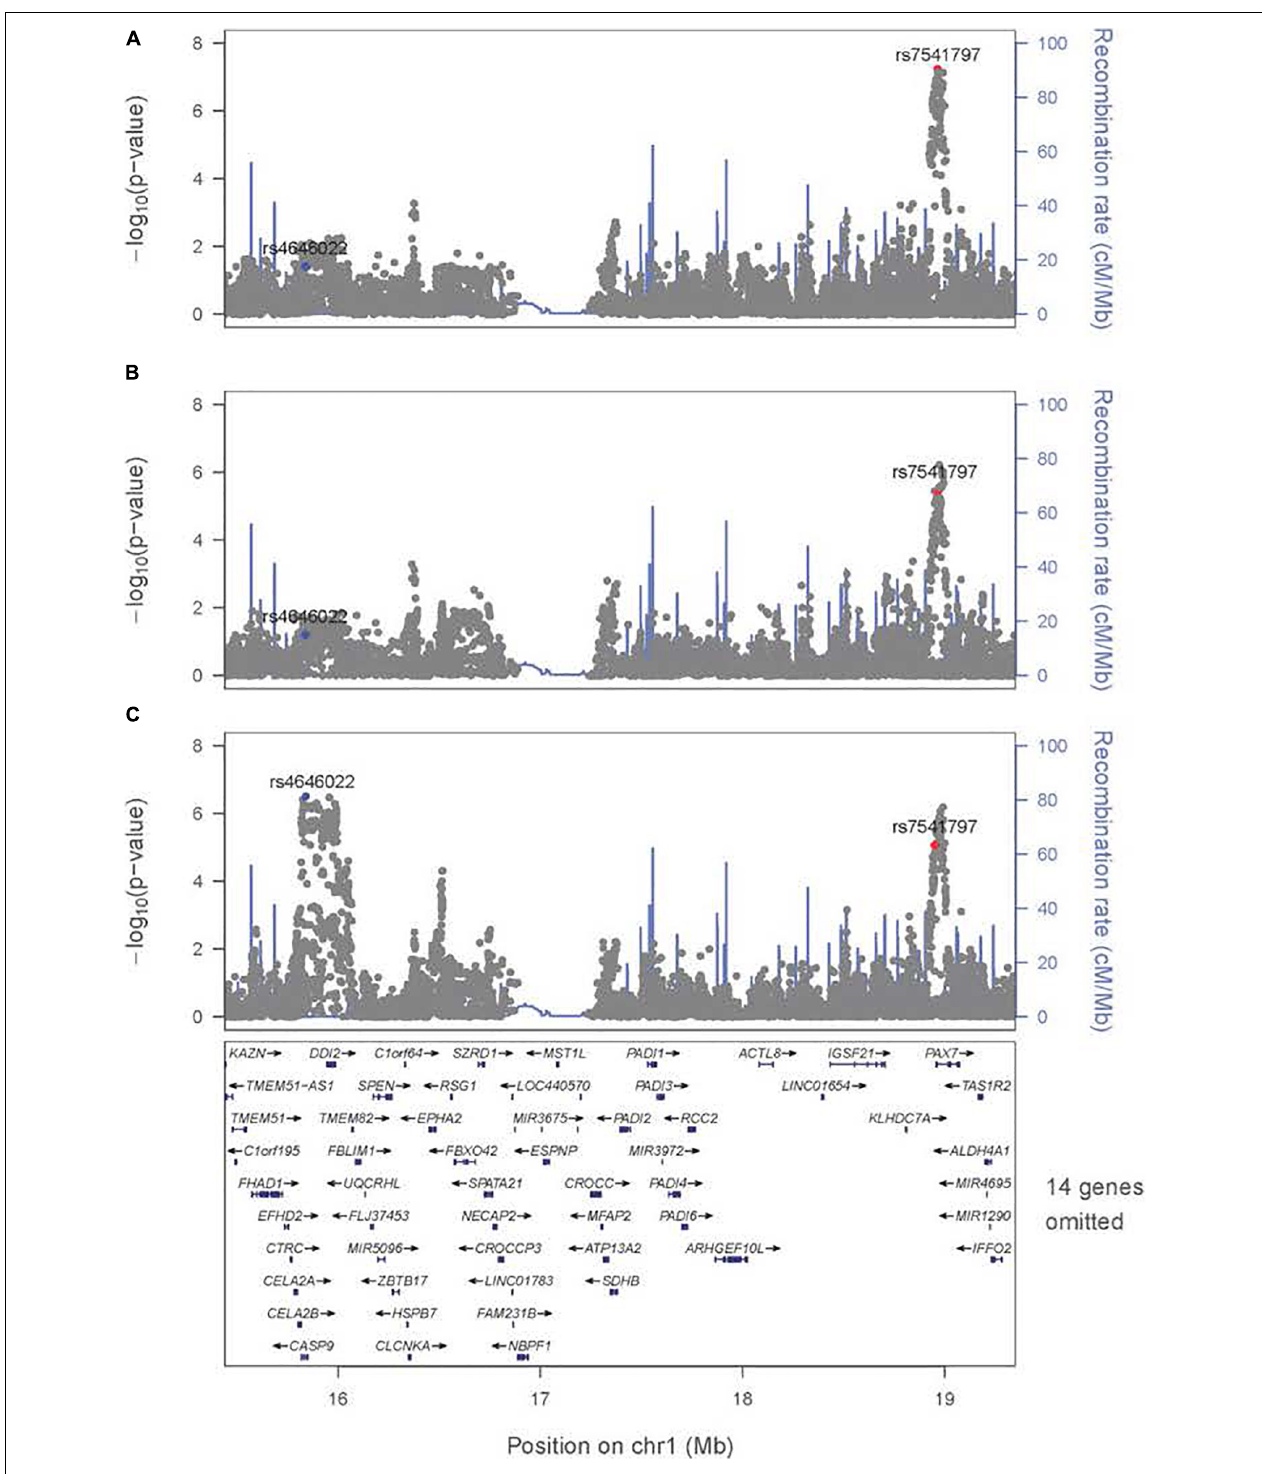
FIGURE 2 | Significance of the 2 df test considering G and G × E interaction for the region on 1p36 encompassing CASP9 and PAX7 . Regional association plot for the 2 df test for (A) G and G × Smoking interaction, (B) G and G × Alcohol interaction, and (C) G and G × Vitamin interaction. The most significant SNP (rs4646022) in the 1 df test for G × Vitamin interaction is denoted in blue; the most significant SNP (rs7541797) in the 2 df test for G and G × Smoking interaction is denoted in red.